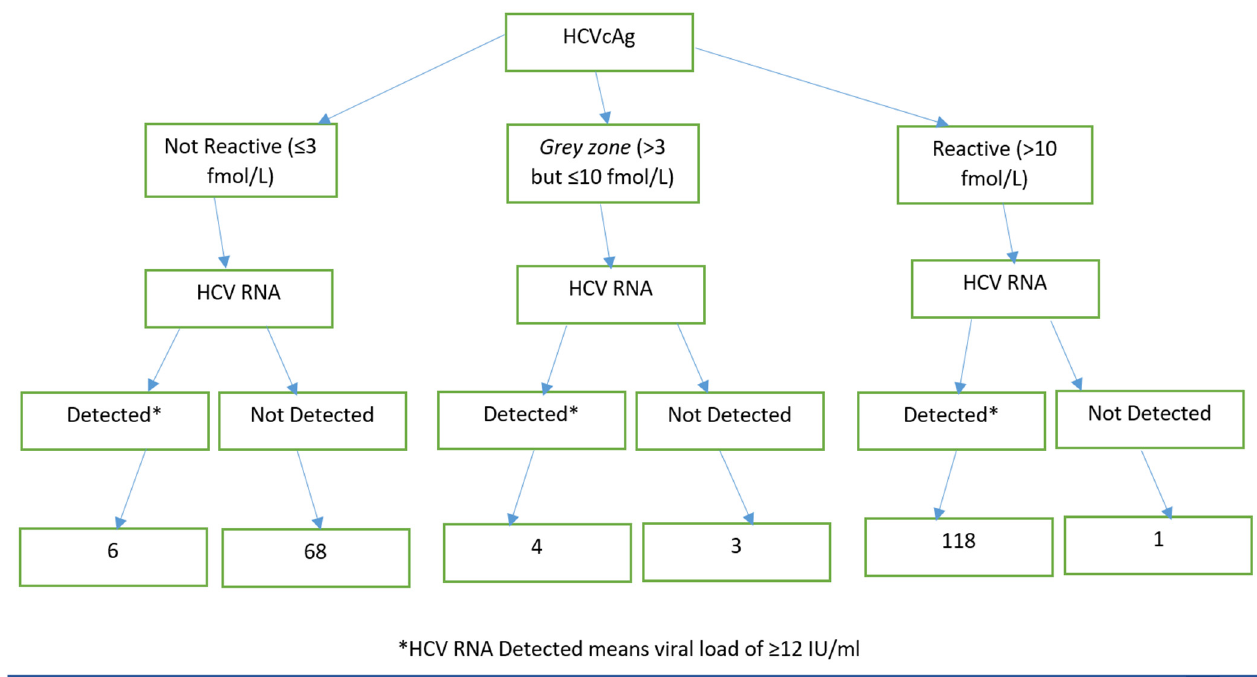
Figure 1. Representation of the results of all study samples ( n = 200). Table 1. Discordant results between of HCVcAg assay ( ≥ 3 fmol/L) and HCV RNA ( ≥ 12 IU/mL) ( n = 10).